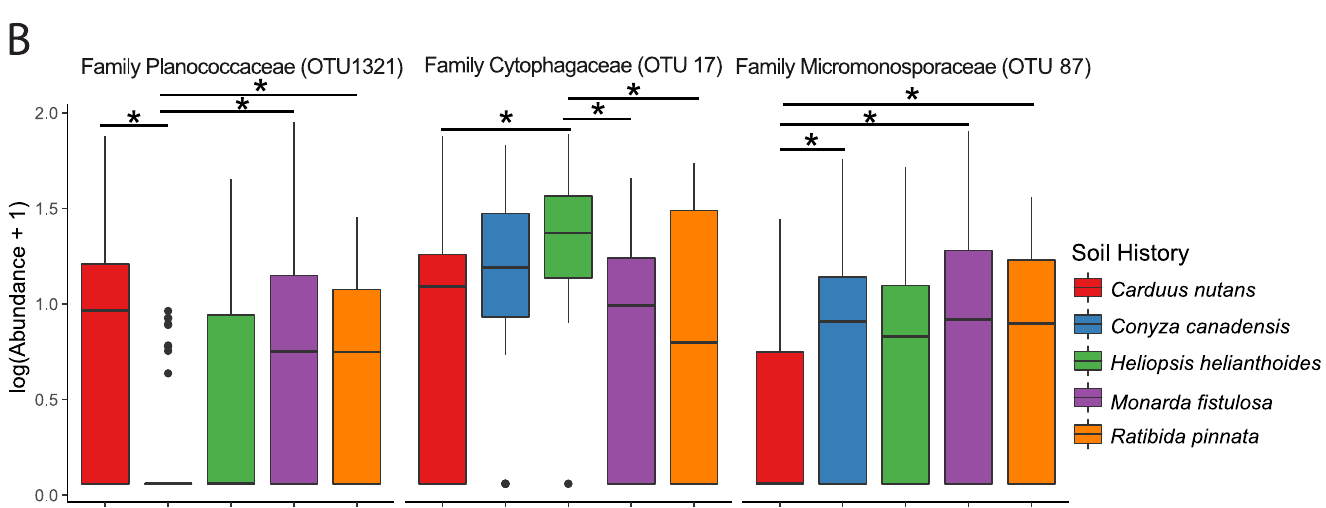
Fig 3. Plant biomass is affected by soil treatment. (A) Bars represent mean total dried biomass across all field soils and all autoclaved field soils with SE. The asterisks indicate statistically significant differences [ANOVA tests with P � 0.05, n = 537]. (B) (C) Box plots of differentially abundant OTUs found across all live soil history [ANCOM (Mann-Whiteny U + FDR correction P � 0.05, n =